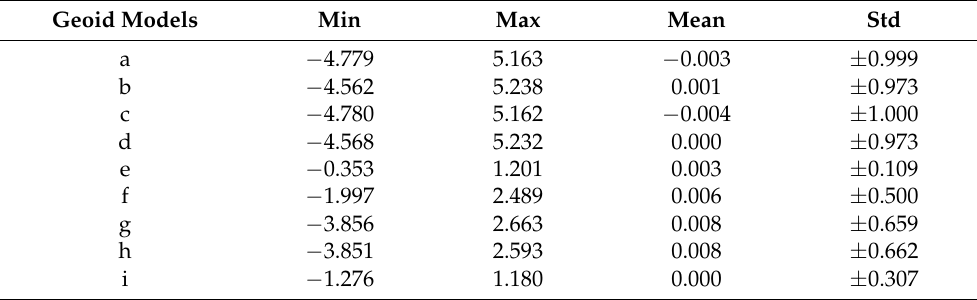
Table 7. Statistics of the residual geoid heights ( N res ) for the various models. Units: (m).